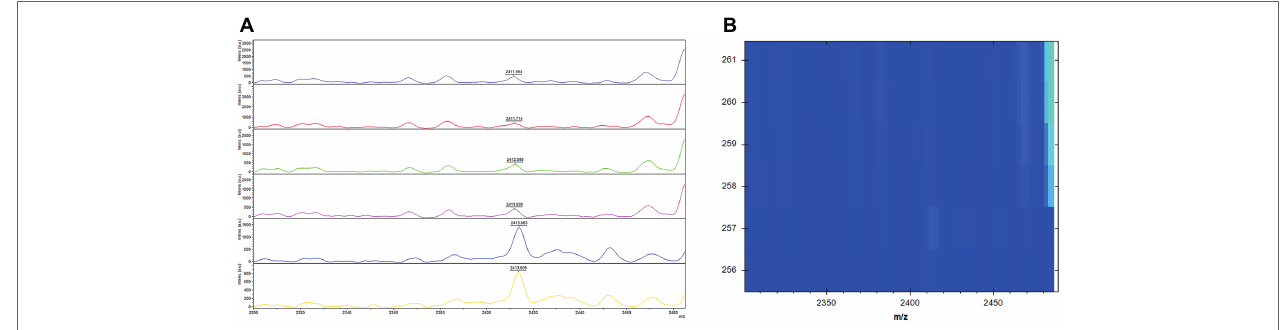
FIGURE 3 | Mass spectra of the characteristic 2,413 m/z peak in the intra batch repeatability and their corresponding normalized spectra in gel view. (A) Mass spectra of the characteristic 2,413 m/z peak analyzed by flexanalysis. The red rectangle displayed peaks at 2,413 2 m/z of the three isolates. (+) and ( − ) represents for PSM-MRSA and MRSA( − ), respectively. x axis, mass per charge in daltons (m/z, Da); y axis, absolute intensity of signal. (B) Normalized spectra in gel view. The red rectangle displayed the corresponding peaks at 2,413 2 m/z of the three